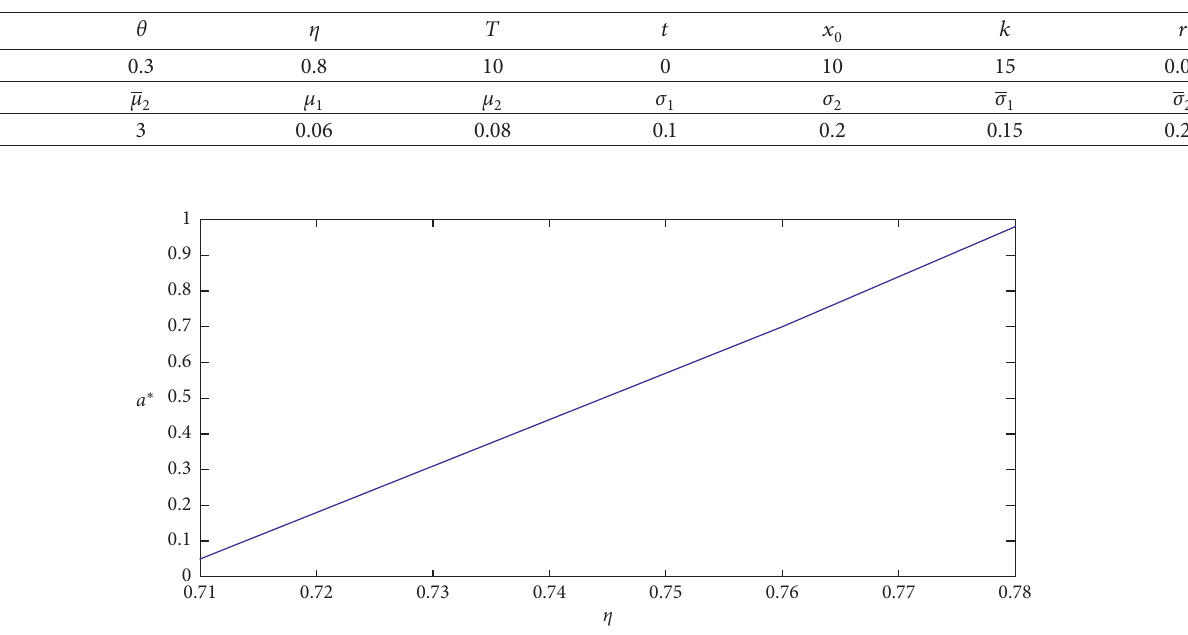
Table 1: Values of model parameters in numerical experiments.